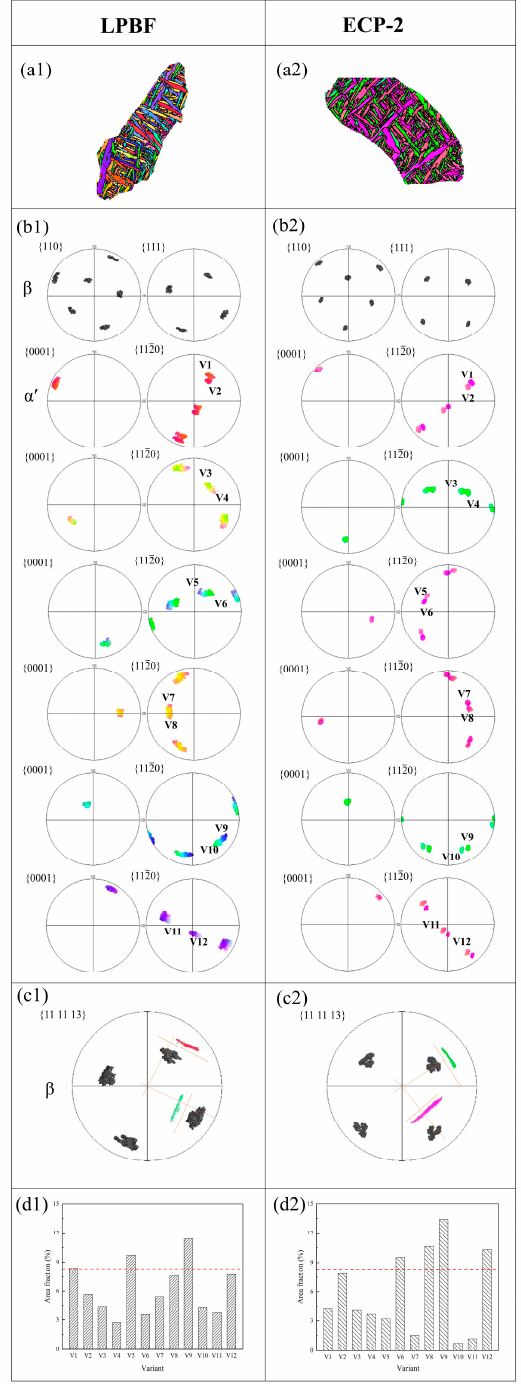
Figure 8. ( a1 , a2 ) are SEM-EBSD micrograph of α (cid:48) martensites in the LPBF-Ti64 sample and the ECP-2 sample. The β matrix is represented with its EBSD band quality contrast and the α (cid:48) martensites with their crystallographic orientation (expressed with the X0 direction inverse pole figure (IPF)). ( b1 , b2 ) are corresponding BOR direction and plane pole figures of the β matrix and the 12 α (cid:48) variants before and after ECP treatment. The poles of the α (cid:48) variants are represented with the consistent colors in ( a1 , a2 ). ( c1 , c2 ) shows {11 11 13} β (habit plane) pole figures with two α (cid:48) variants before and after ECP treatment. ( d1 , d2 ) Area fractions of the 12 α (cid:48) variants before and after ECP treatment. The red dotted line in ( d1 , d2 ) refer to the random average distribution of 8.33%